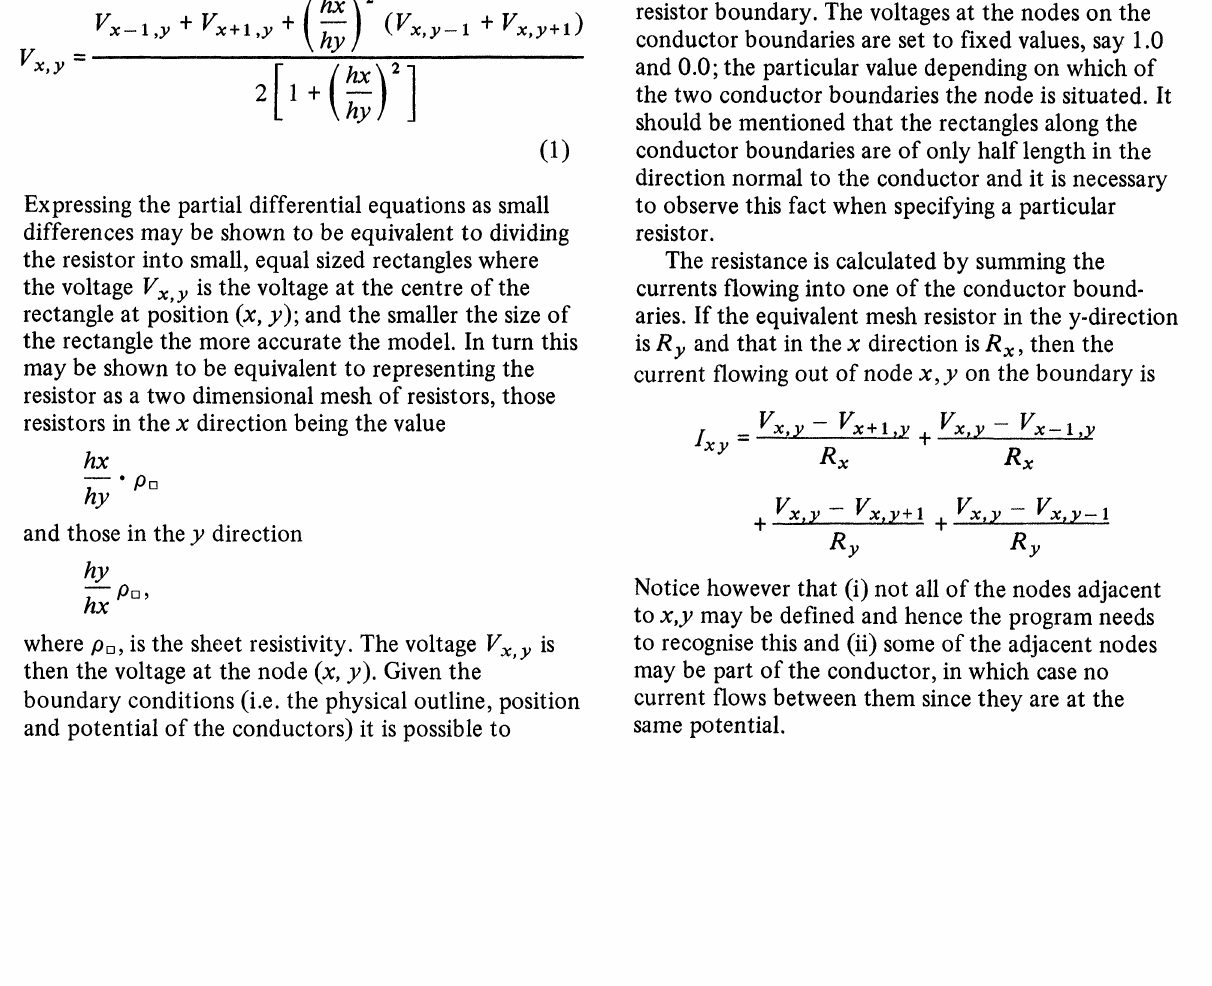
FIGURE Physical interpretation of finite difference approximation to LaPlace’s equation (a) Small rectangles (b) Resistor